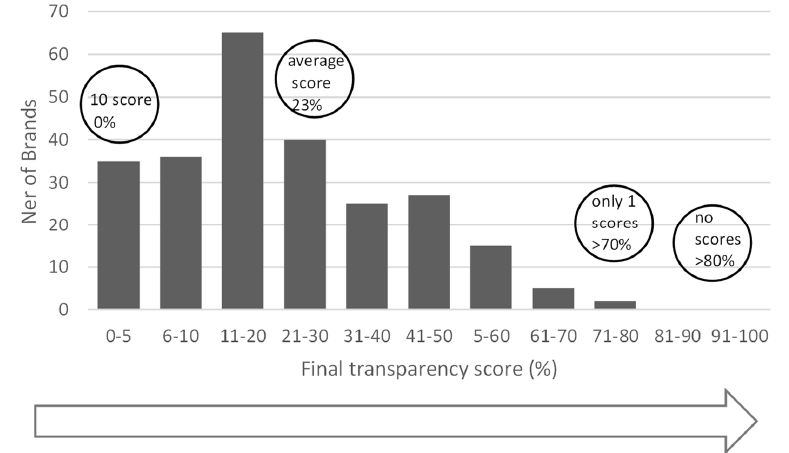
Figure 7. Quantity of companies versus the Transparency Index (in percent; 100% corresponds to a maximum of 220 points).